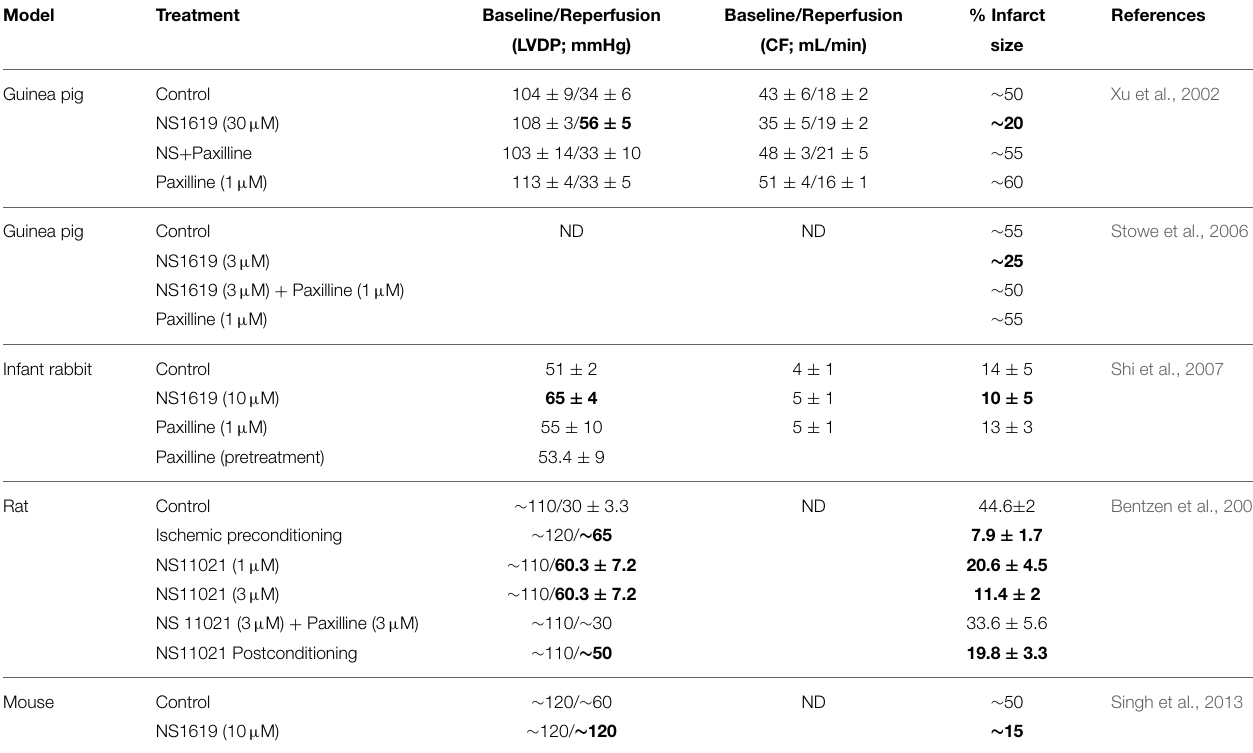
TABLE 2 | BK Ca channel agonists and